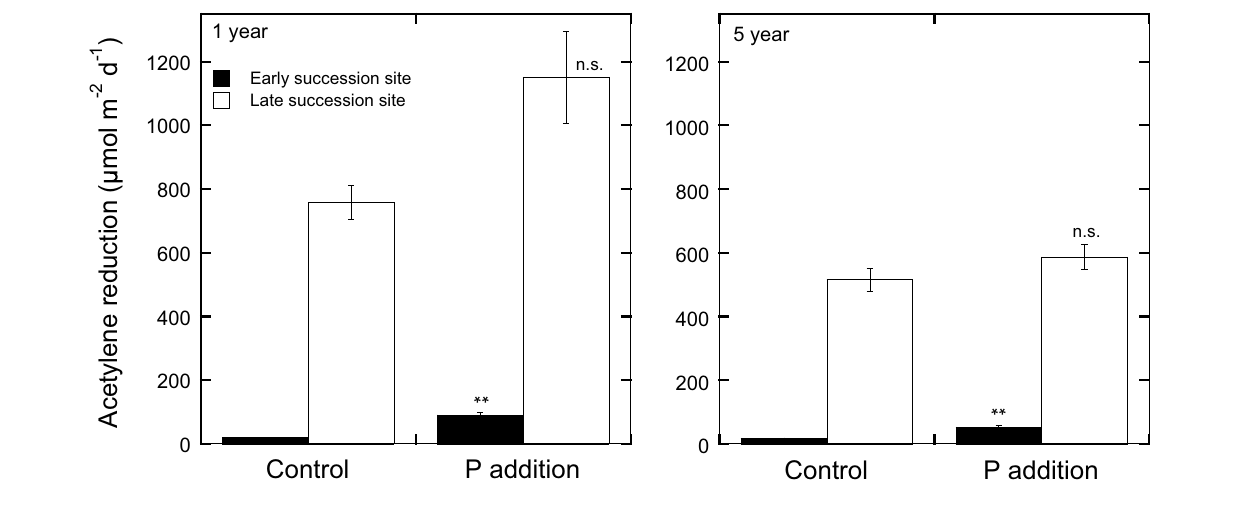
1.0m 2 plots in four doses over the course of the summer. Distilled water was applied to the control plots. Mean values ( n = 10) and + 1 SE are given, ∗∗ represents significant at P < 0 . 05 and n.s. represents not significant as determined by a One-Way ANOVA. Experimental design, sampling, and data analyses are reported for year-one in Zackrisson et al.